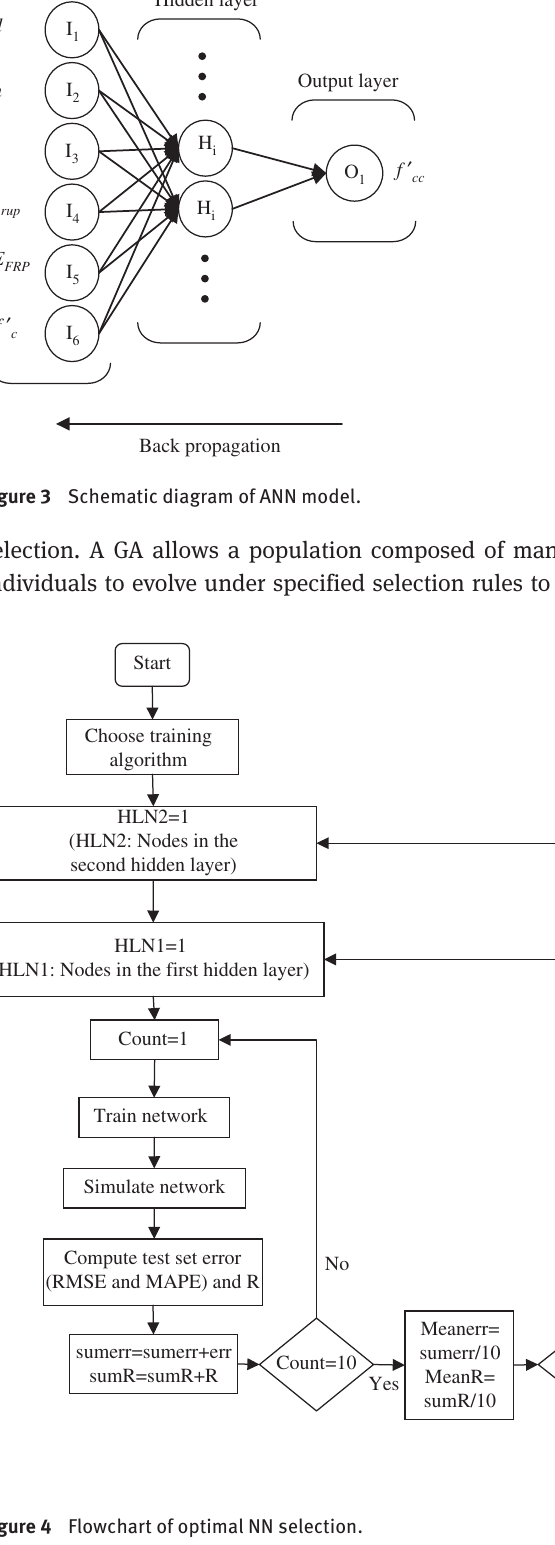
Figure 4 Flowchart of optimal NN selection.